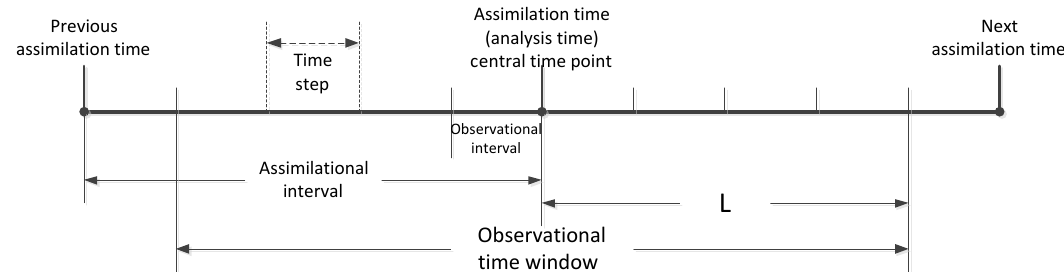
Figure 1. The schematic for the assimilation interval, the length of the OTW, as well as the observational interval in terms of the model integration time step. Here L represents the time steps at one side of the OTW. For example, OCN-OTW ( L ) in the content stands for an ocean observational time window with total observations of 2 L +